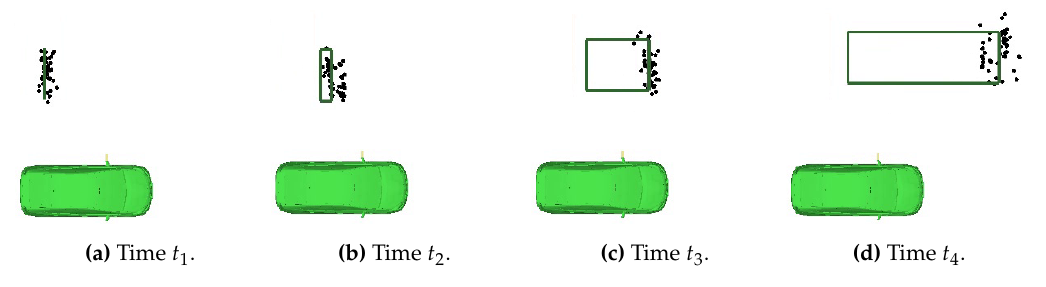
Figure 8. As a vehicle (possible positions in black) overtakes the host (in green), its length is recursively being refined (rectangle), here t 1 < t 2 < t 3 < t 4